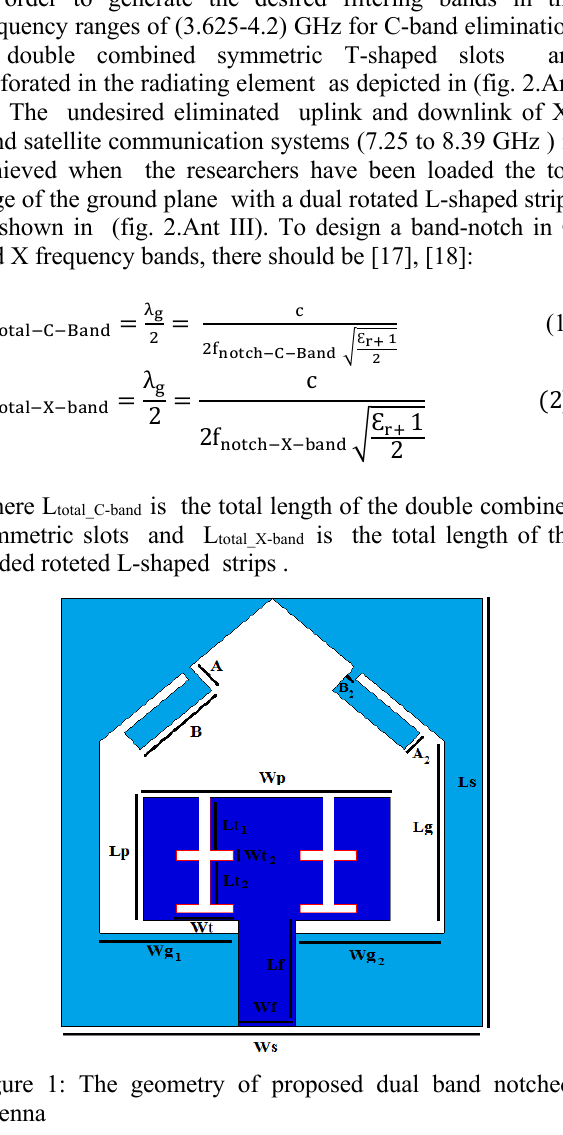
Figure 1: The geometry of proposed dual band notched antenna